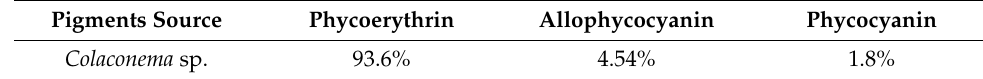
Figure 1. Detection of the purified phycoerythrin (PE) of Colaconema sp. via ( A ) native PAGE and ( B ) SDS-PAGE. Native and SDS gels electrophoresis were run in 8% and 15% gel, respectively. ( A ) Table 2. The ratio in phycoerythrin (PE), allophycocyanin (APC), and phycocyanin (PC) concentration of purified pigments of Colaconema sp.